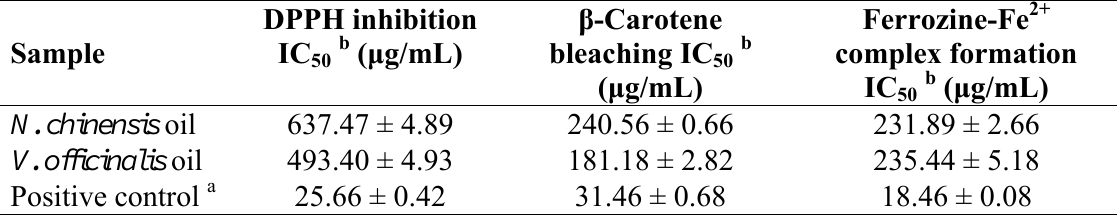
Table 3. Antioxidant activity of the essential oils from N. chinensis and V. officinalis .